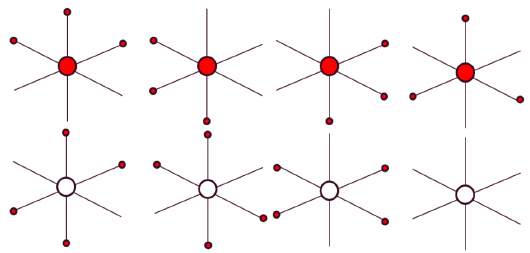
FIG. 23. Graphical representation of the stabilizer elements that only contain Z or I operators. An identical set applies when we switch Z to X . Disks colored red denote Pauli Z s acting on the corresponding